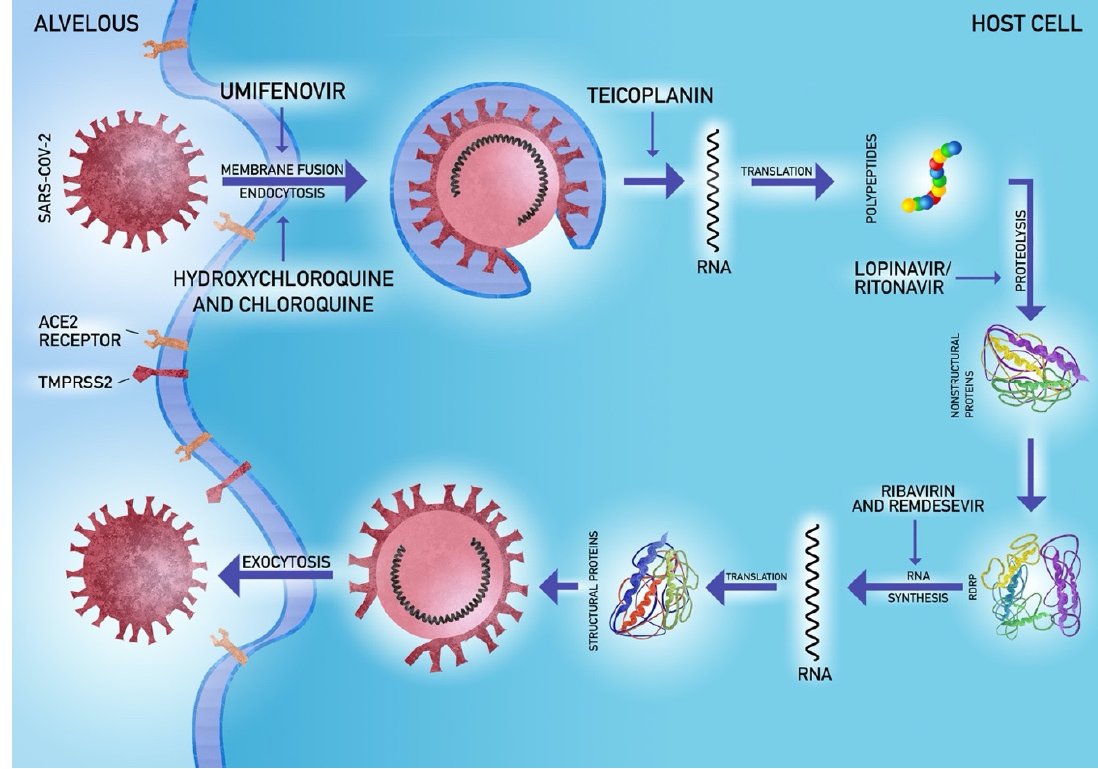
Figure 2. Antiviral treatment in COVID-19.